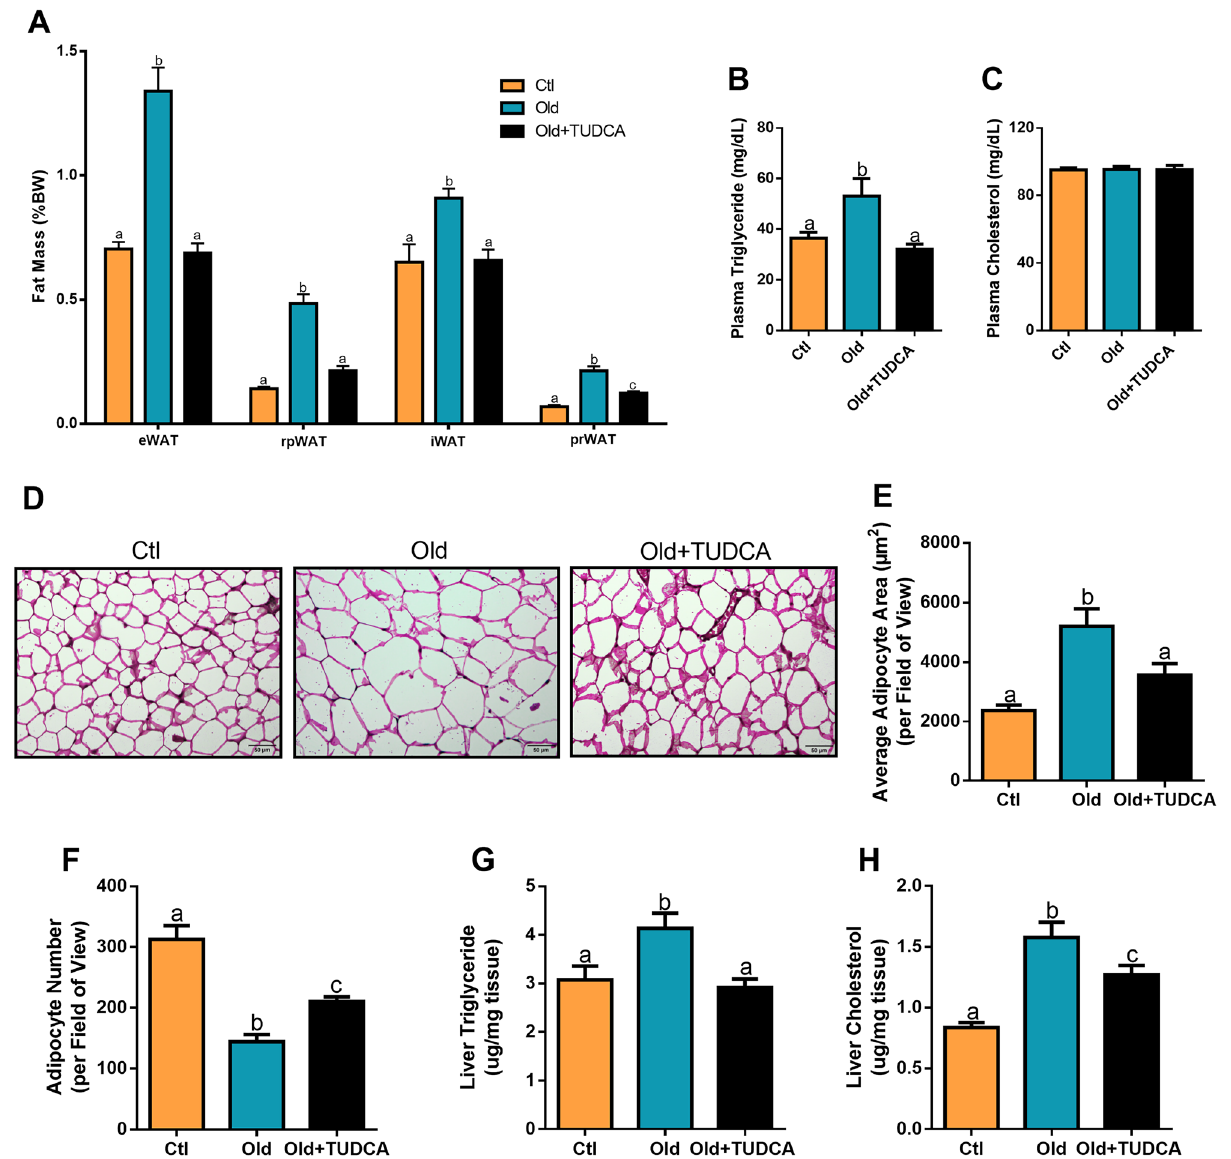
Figure 2. Effects of TUDCA treatment upon fat depots and liver lipids accumulation. Epididymal (eWAT), retroperitoneal (rpWAT), inguinal (iWAT), and perirenal (prWAT) fat pads weight ( A ). Serum triglyceride ( B ) and cholesterol ( C ). H&E sections of Ctl, Old, and Old + TUDCA in eWAT ( D ) (scale bar 50 µm, 20 × magnification). Epididymal WAT adipocyte area ( E ) and number ( F ). Liver triglyceride ( G ) and cholesterol ( H ) content. Data are presented as mean ± SEM (n = 5–10). Statistical analysis was performed using the one-way ANOVA test, followed by Tukey post-hoc-test. Letters shared in common between groups indicate no significant difference. Different letters (a, b, and c) indicate statistical difference between groups (P ≤